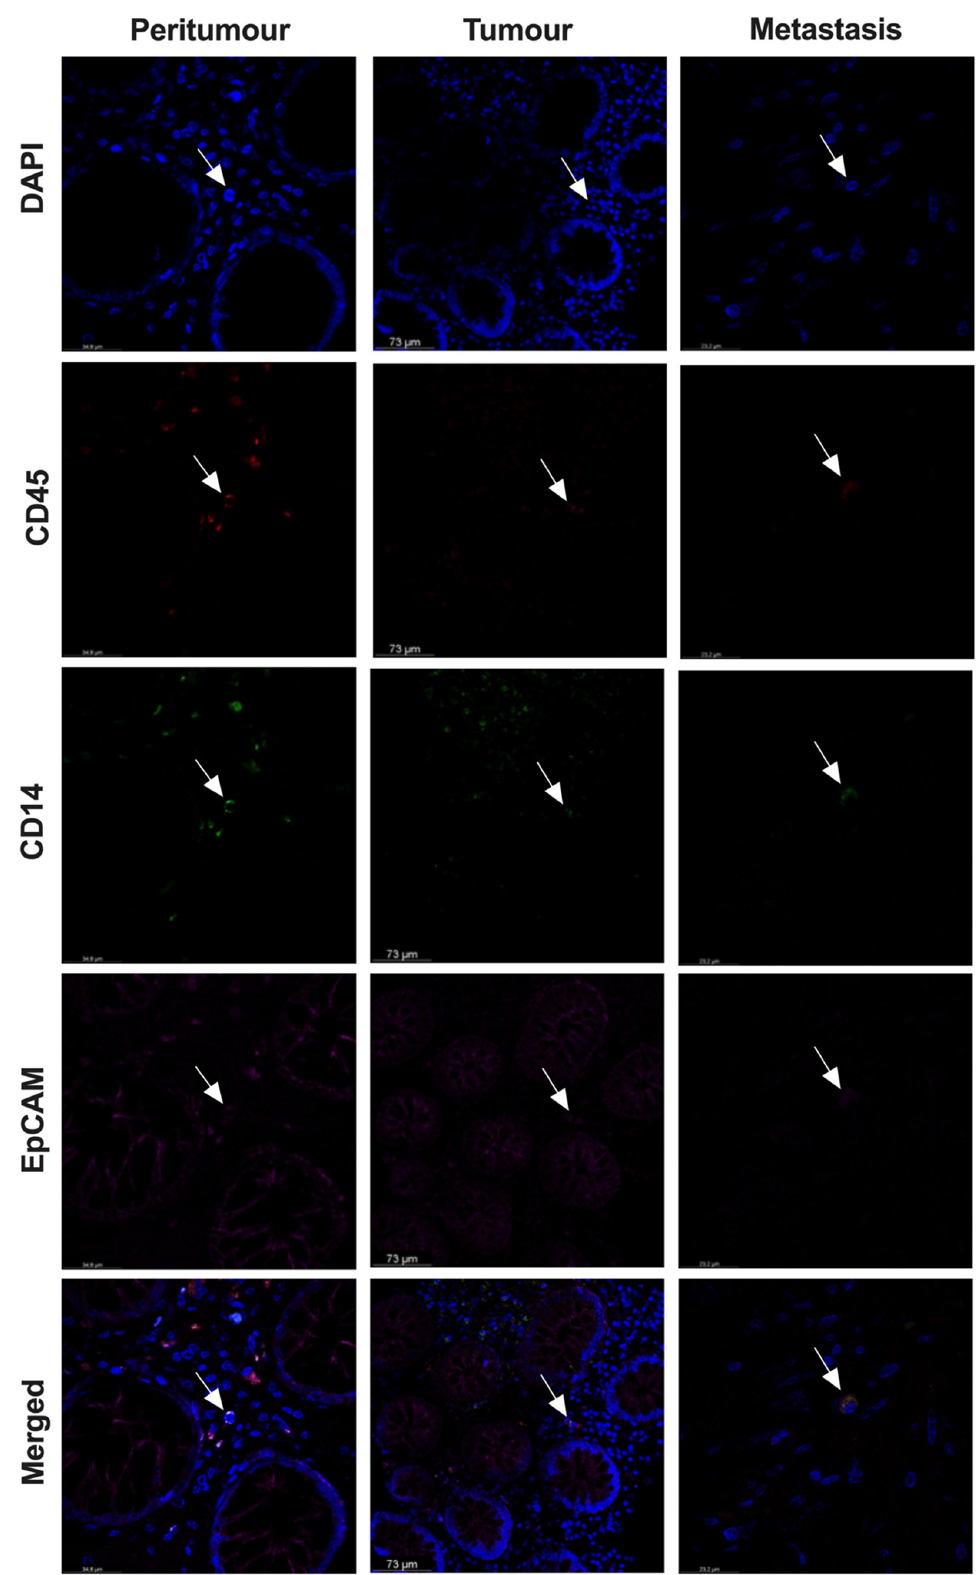
Figure 7. THCs are present in paired peritumoural, tumoural and metastatic tissue samples from CRC patients. Representative confocal images of DAPI + (nucleus, blue), CD45 + (red), CD14 + (green), EpCAM + (pink) and merged at 63 × magnification. Co-expression of all markers in merged can be observed in tangerine (THCs). Arrow indicates a cell with co-expression of all markers.